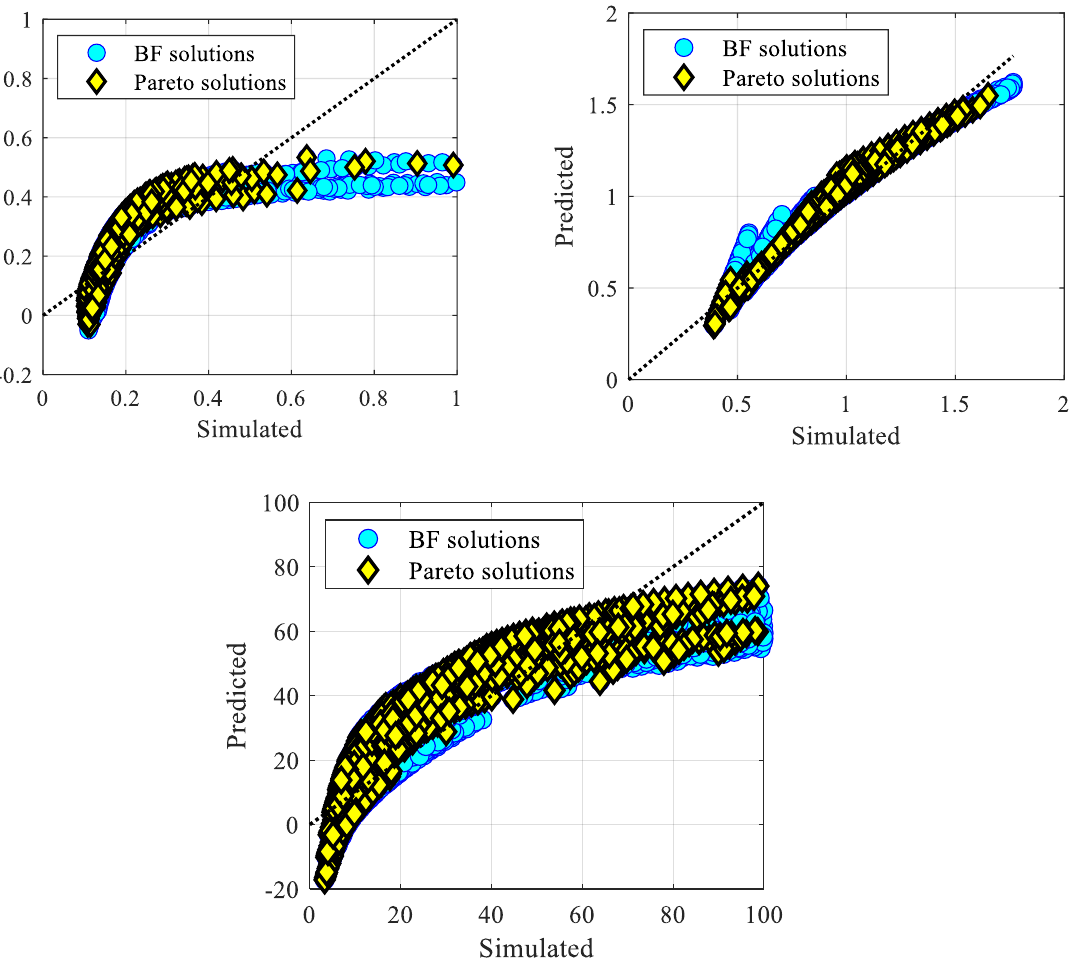
Figure 5. Comparisons between predicted (multiple − linear regression) and simulated solutions for both BF and Pareto solutions the three different objective functions investigated ( j = 1, 2, and 3, from the left, to the right, to the bottom).